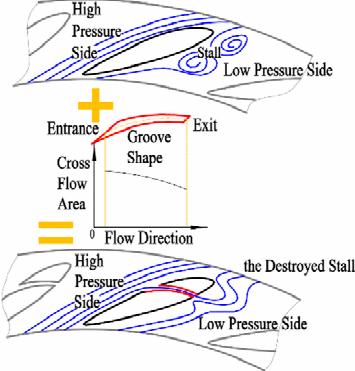
Figure 6. Mechanism of “Groove Method” to suppress stall.